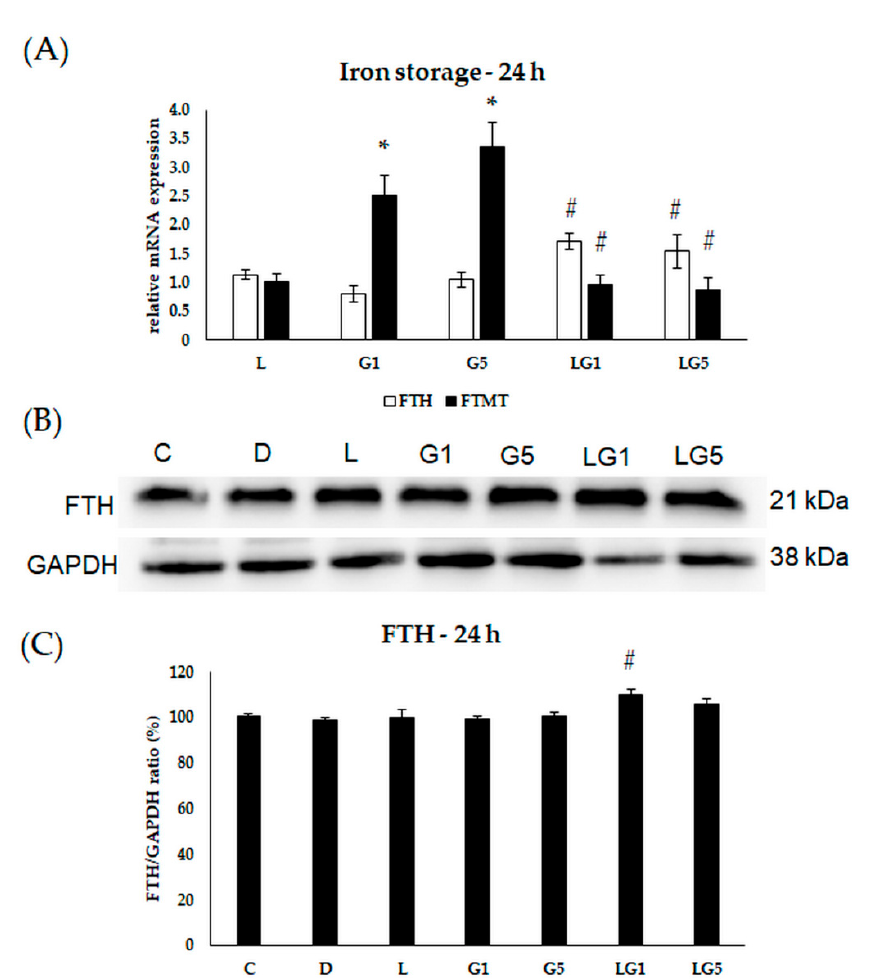
Figure 9. Determination of mRNA expression ( A ) and protein ( B , C ) levels of iron storing FTH and FTMT after lutein and Glu treatments of the SH-SY5Y cells at 24 h. SH-SY5Y cells were treated with 10 ng/µL of lutein, 1 mM, 5 mM Glu, or lutein with Glu together to detect the changes in the expression of FTH and FTMT. The gene expression measurements were performed by SYBR Green RT-PCR protocol using β -actin as a housekeeping gene, the relative expression of controls was regarded as 1. The protein expression measurements were performed by semi-dry Western blotting using GAPDH as a loading control. The protein’s OD was expressed as a percentage of the target protein/GAPDH ratio. The bars represent the mean values (±standard deviation error bars, SD) of three independent experiments ( n = 3) performed in triplicate and are presented relative to their control cells. The * marks the statistical significance of Glu treatments compared to control, # shows the statistical significance of combined (lutein with Glu) treatments compared to the Glu treatments at 24 h ( p < 0.05).